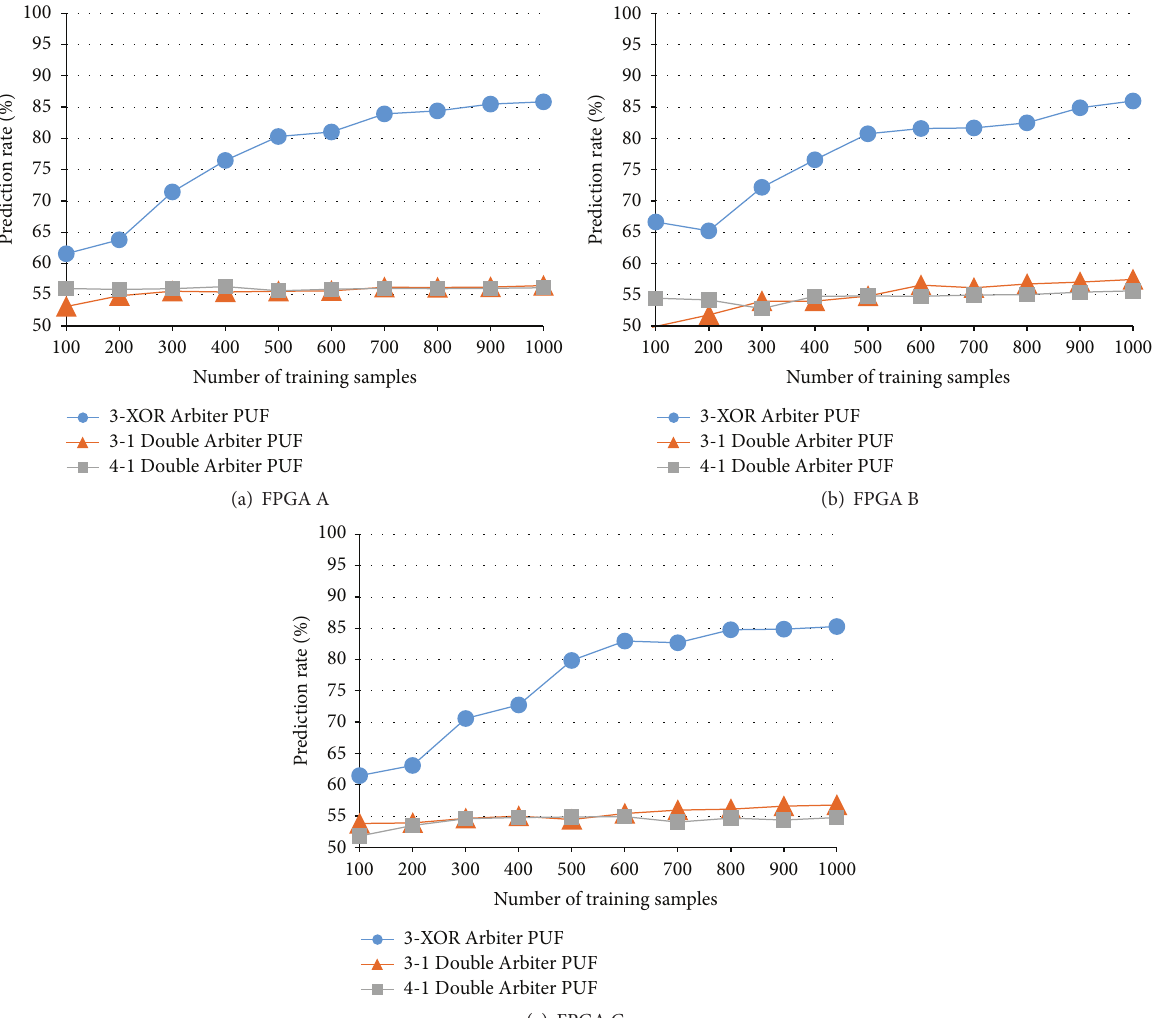
Figure 12: Prediction rates of 3-XOR Arbiter PUF and 3-1 and 4-1 Double Arbiter PUF.